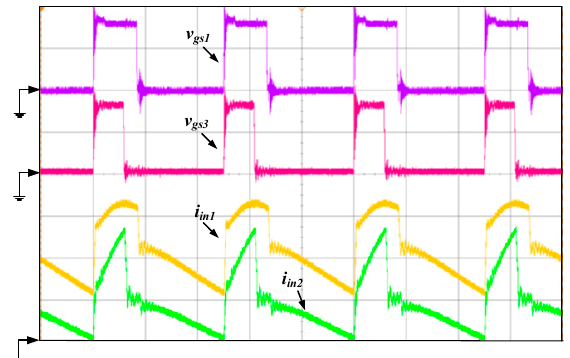
Figure 11. Control block diagram of the proposed converter.